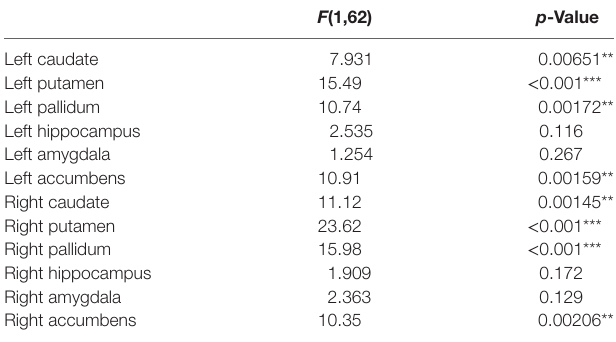
The table lists the F-statistics and p values of the linear regression model. lm(volume ~ age) for all patients. **Uncorrected p < 0.01. ***p <